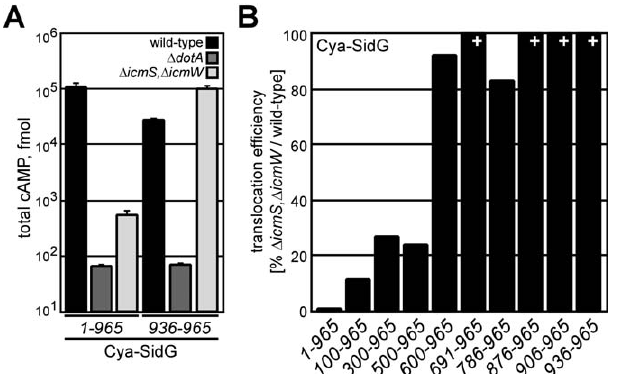
Figure 4. The C-Terminal Translocation Signal of SidG Supports icmSW - Independent Translocation (A) CHO Fc c RII cells were infected with wild-type (black), D dotA (dark grey), or D icmS , D icmW (light grey) strains expressing indicated Cya-SidG hybrid proteins for 1 h. Total cAMP production induced by translocation of the hybrid was determined as in Figure 1. (B) CHO Fc c RII cells were infected with wild-type or D icmS , D icmW strains expressing the indicated Cya-SidG hybrid proteins for 1 h. Total cAMP production induced by translocation of the hybrid was determined for each strain. % values represent translocation efficiency as a measure of ( D icmS , D icmW ) / wild-type for the indicated Cya-SidG hybrid proteins. þ indicates that cAMP production induced by translocation of the hybrid in D icmS , D icmW exceeded levels produced in wild-type.